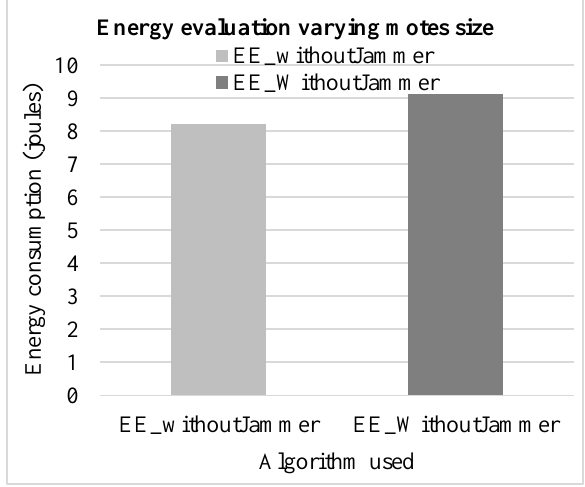
Figure 4 Energy efficiency performance considering varied number of UWSN motes .